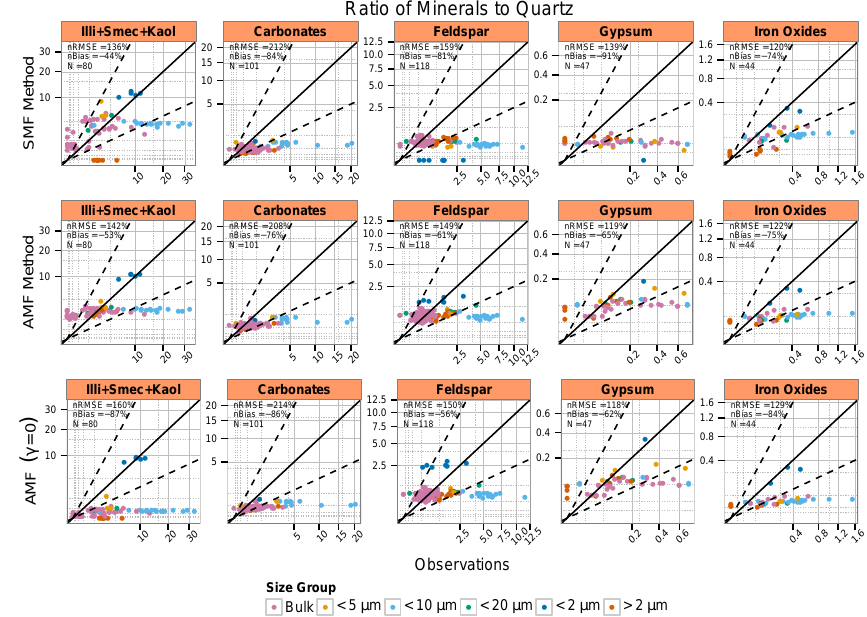
Figure 8. Measured vs. simulated mineral ratios with respect to quartz for the SMF, AMF and AMF ( γ = 0) methods. The dashed lines mark a ratio of 2 : 1 and 1 : 2 between the simulated and observed mineral ratios. respect to quartz are fairly constant within each size